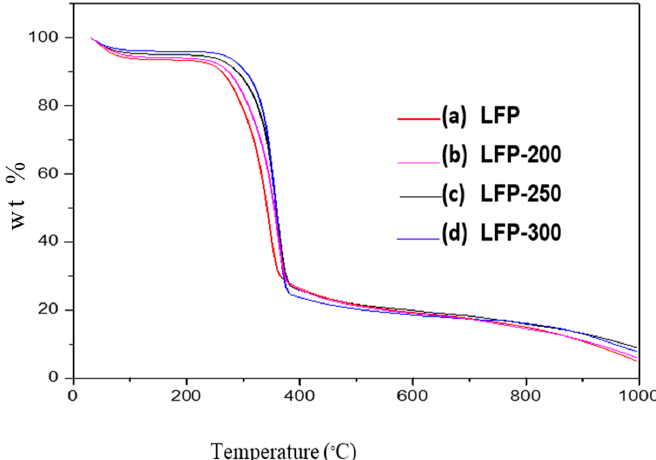
Figure 1. Thermogravimetric curves for ( a ) Raw Dimocarpus longan peelpowder (LFP) and their corresponding carbon micro-spheres produced at various temperatures ( b ) LFP-200; ( c ) LFP-250; and ( d ) LFP-300.